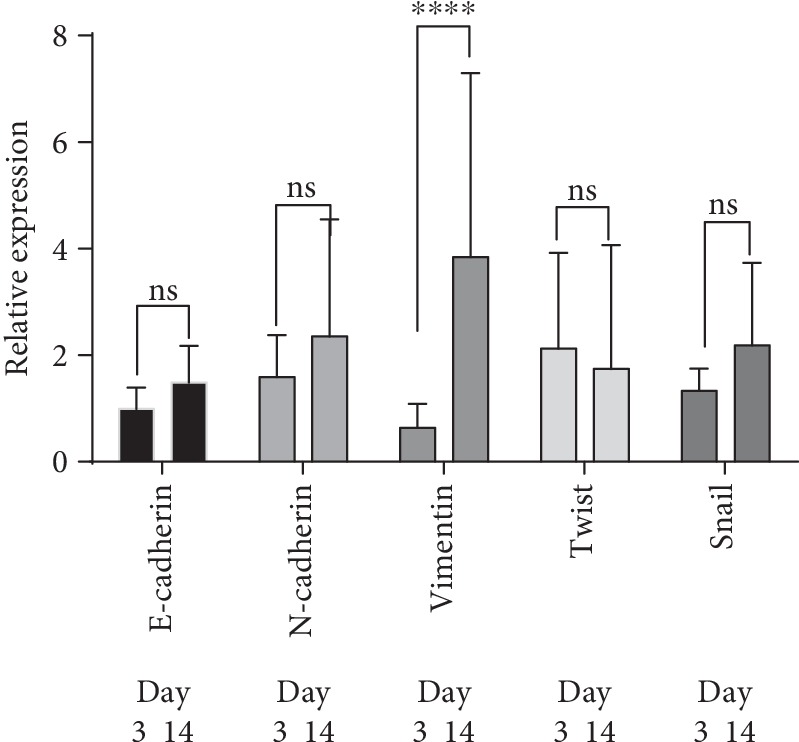
Relative expression levels of EMT markers in the derivatives of 4T1luc2 cells expressing variants of consensus HIV-1 FSU_A reverse transcriptase (Table 2) after 3 and 14 days in culture. Expression level was normalized to HPRT1 expression and calculated as fold change compared to the parental 4T1luc2 line. Results are presented as mean ± SD from two independent assays run in duplicates. ns: not significant; ∗∗∗∗p < 0.0001 by the ordinary two-way ANOVA.